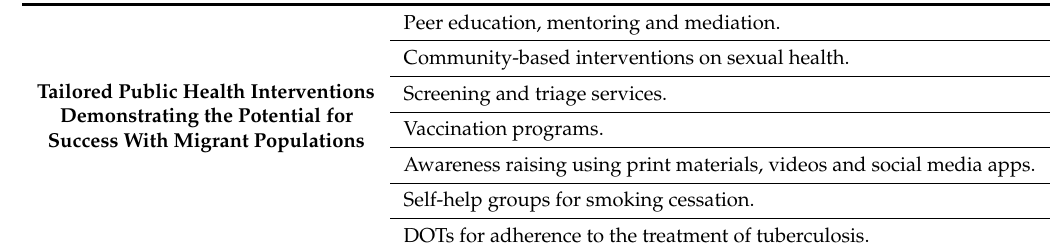
Table 1. Tailored interventions for migrant